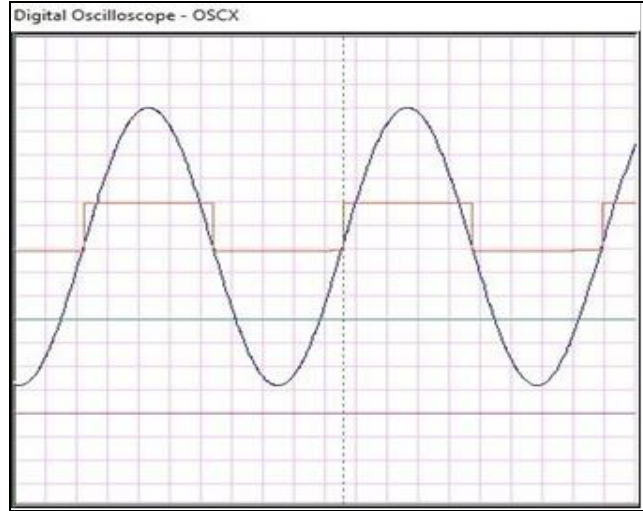
Figura 8: Gráfica obtenida del detector de cruce por 0, para la sincronización, en